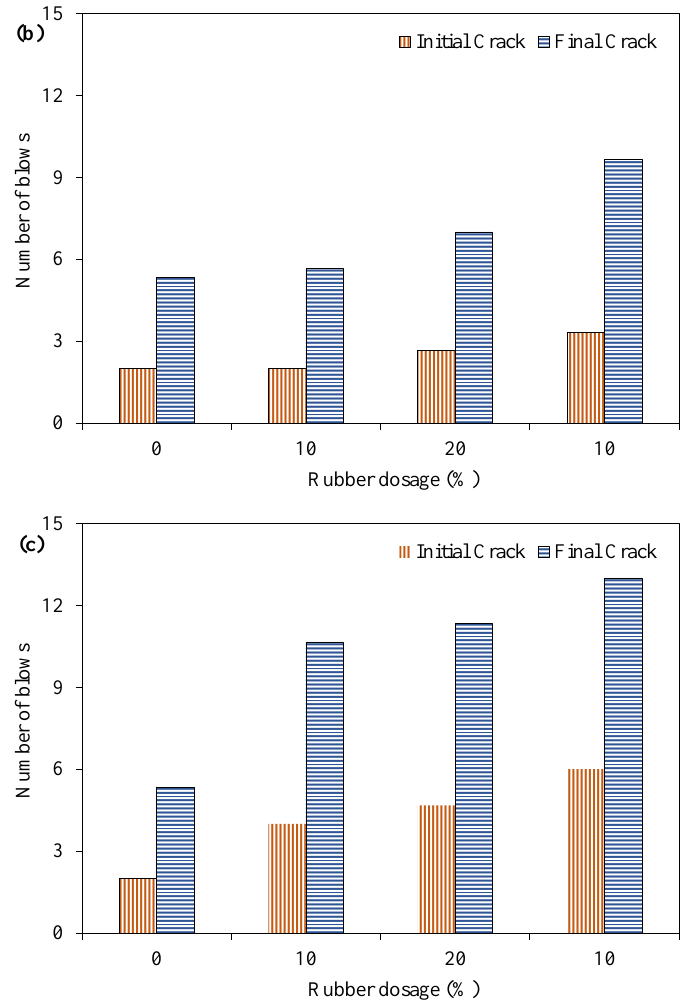
Figure 14. Number of blows for the initial and final cracks under the impact load for various dosages of rubber: ( a ) R1, ( b ) R5, ( c ) R10.